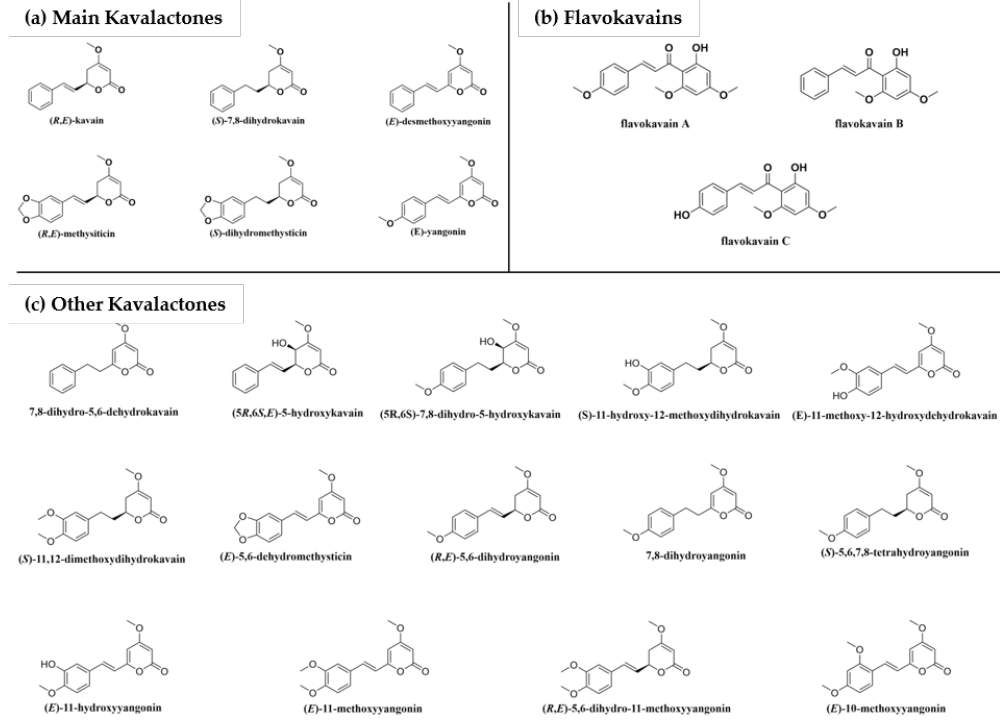
Figure 3. ( a ) Main kavalactones; ( b ) flavokavains; and ( c ) minor kavalactones in kava.